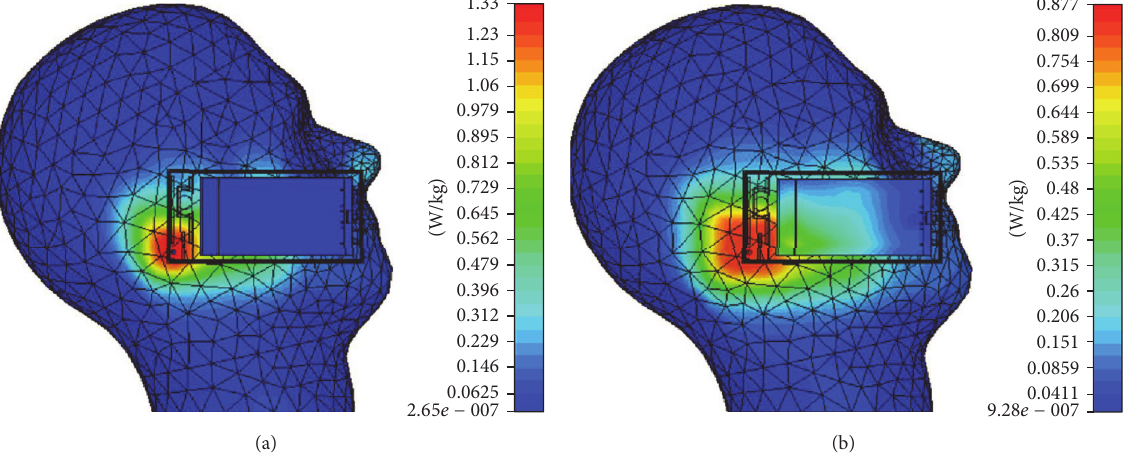
Figure 16: SAR distribution at 3400 MHz: (a) average 1-g and (b) average 10-g.